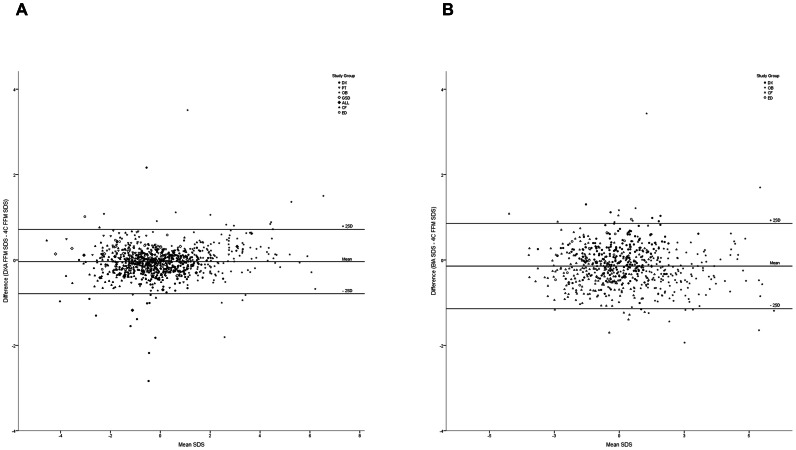
Bland-Altman analyses for the agreement between the 4C model and (A) DXA and (B) BIA in the measurement of FFM.As for Figure 1, SD scores (SDS) were calculated using ICH reference data [2]. Difference in SDS between techniques was calculated by subtracting 4C FFM SDS from the FFM SDS given by the ‘simpler’ method. Horizontal lines on the graph indicate the mean difference between techniques, and two standard deviations above and below this value. Different symbols indicate which study group each subject was from, as shown in the key. 4C model; four-compartment model, DXA; dual-energy X-ray absorptiometry, BIA; bioelectrical impedance analysis. DX; healthy children, PT; young adults born preterm, OB; obese children, GSD; glycogen storage disease, ALL; acute lymphoblastic leukaemia, CF; cystic fibrosis, ED; eating disorders.